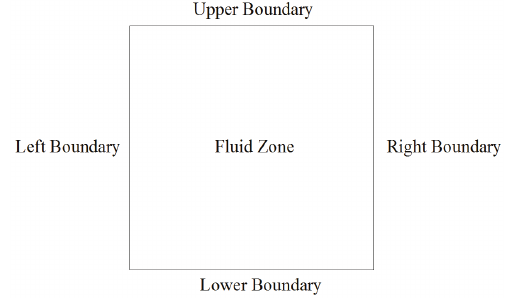
Figure 2. The setting of the computational domain.